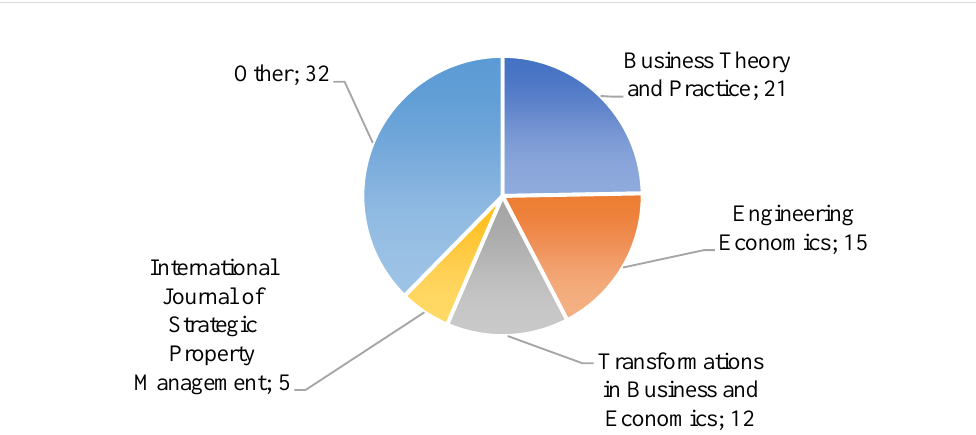
Fig. 4. Documents by the source